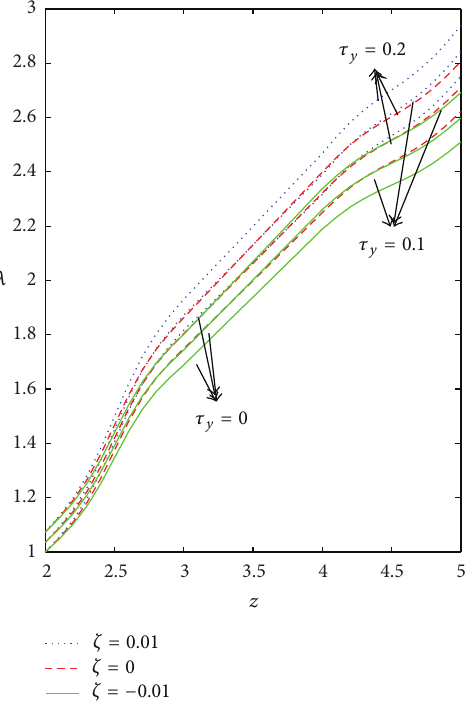
Figure 10: Axial variation of flow resistance ( 𝜆 ) for different values of 𝑛 taking 𝑘 = 1.2 , 𝜏 𝑦 = 0.1 , and 𝛿 = 0.2 .